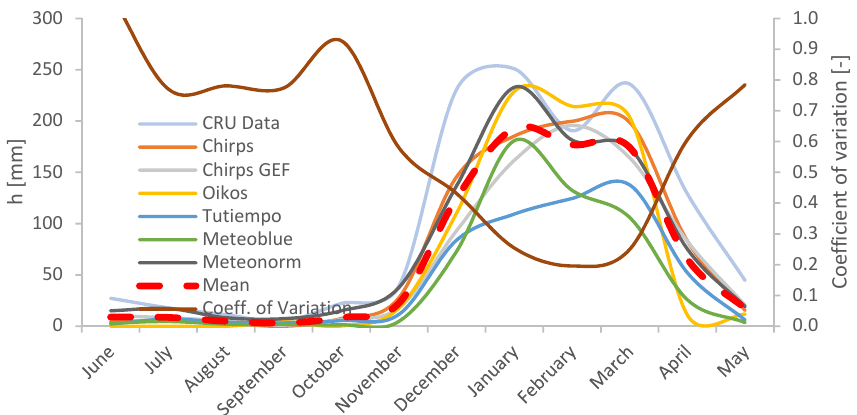
Figure 7. Comparison of the average monthly distribution of all the sources, coefficient of variation and mean curves.